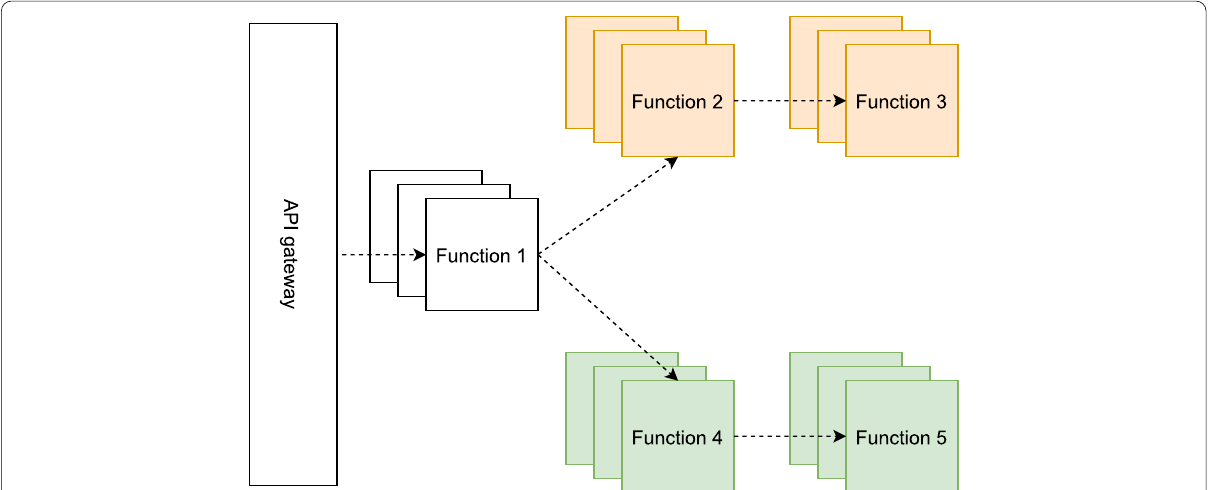
Fig. 2 This figure illustrates an application composed by various functions chained together. Let us assume that Function 1 is responsible for authenticating the application’s administrators as well as end-users before their requests are passed to other functions. Imagine that the request is passed to Function 2 and Function 3 if the request originates from administrators, while if the request comes from end-users this is handled by Function 4 and Function 5. In such a case, the application’s control flow can easily leak the role of the person issuing the request or the times